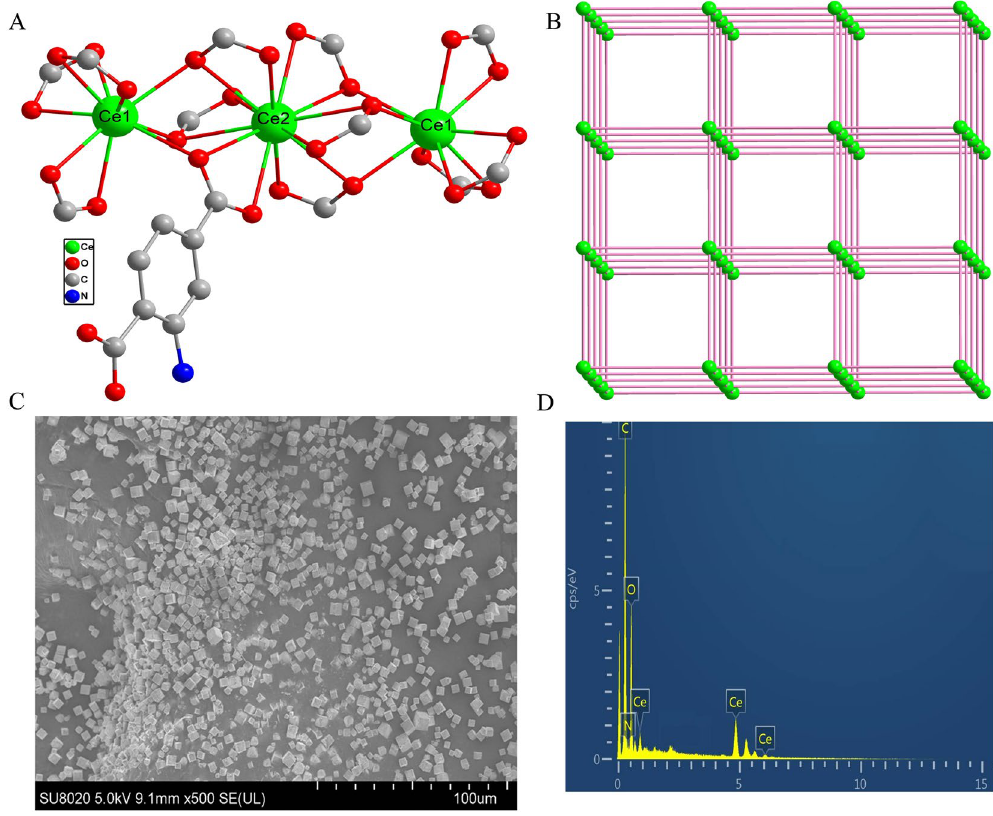
Figure 2. ( A ) Coordination environments of Ce 3 + ions and H 2 L; ( B ) the 3D topological structure of Ce-MOF; ( C ) SEM image of Ce-MOF; ( D ) EDX analysis of